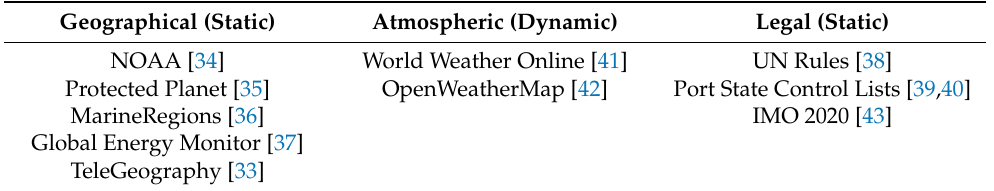
Table 1. Database Charters and